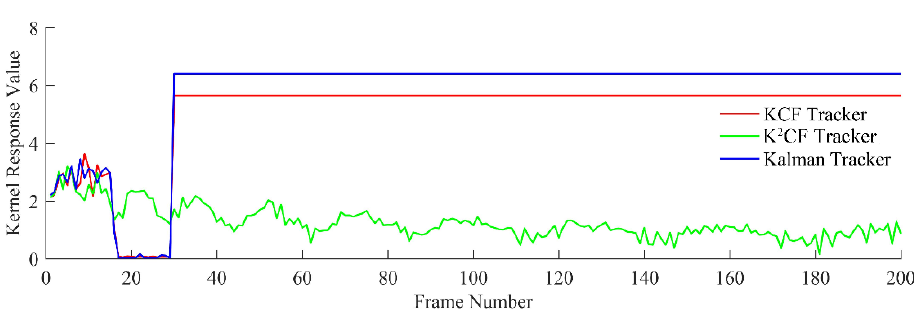
Figure 18. Kernel response value of nonuniform state.